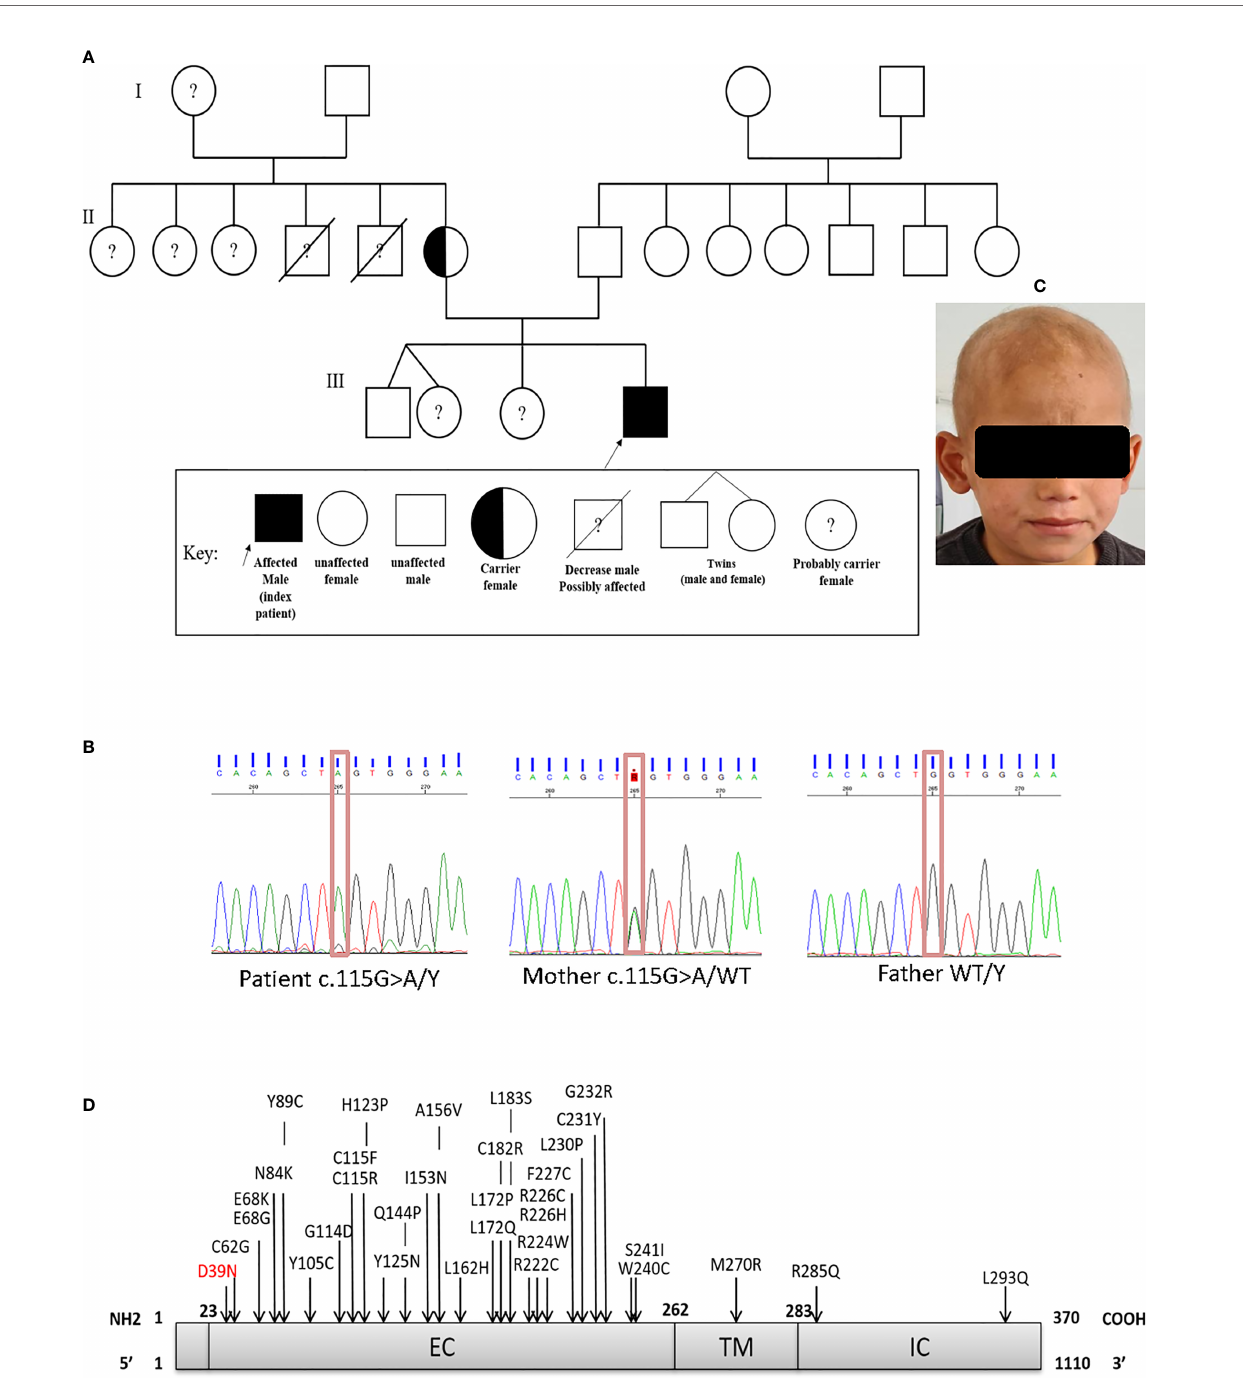
FIGURE 1 | (A) Family pedigree of the patient. (B) Sanger sequencing con fi rmed the presence of the mutation in exon 1 (c.115G>A; p.Asp39Asn). The heterozygous (mother) and WT states. (C) Scarring alopecia, hypotrichosis with ringworm of the scalp. (D) Schematic diagram of the IL-2RG protein, with its extracellular (EC), transmembrane (TM), intracellular (IC) domains. In red the mutation carried by the patient and in black the positions affected by the mutations already described in the